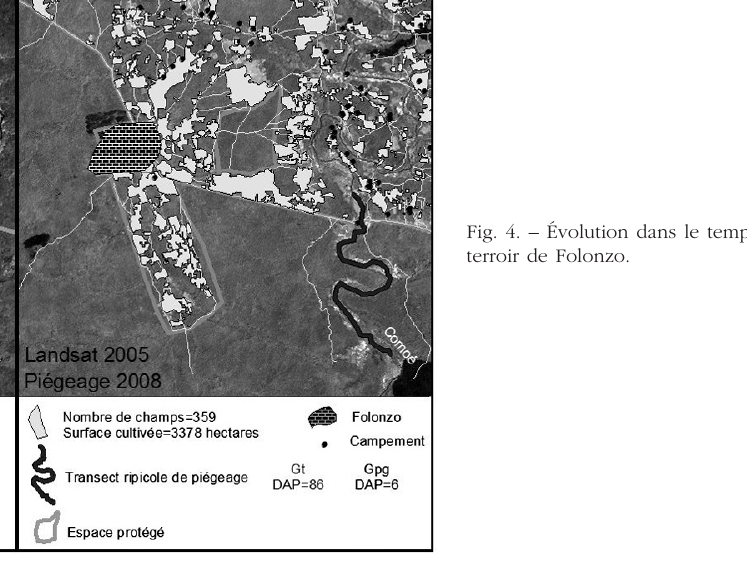
Fig. 4. – Évolution dans le temps du terroir de